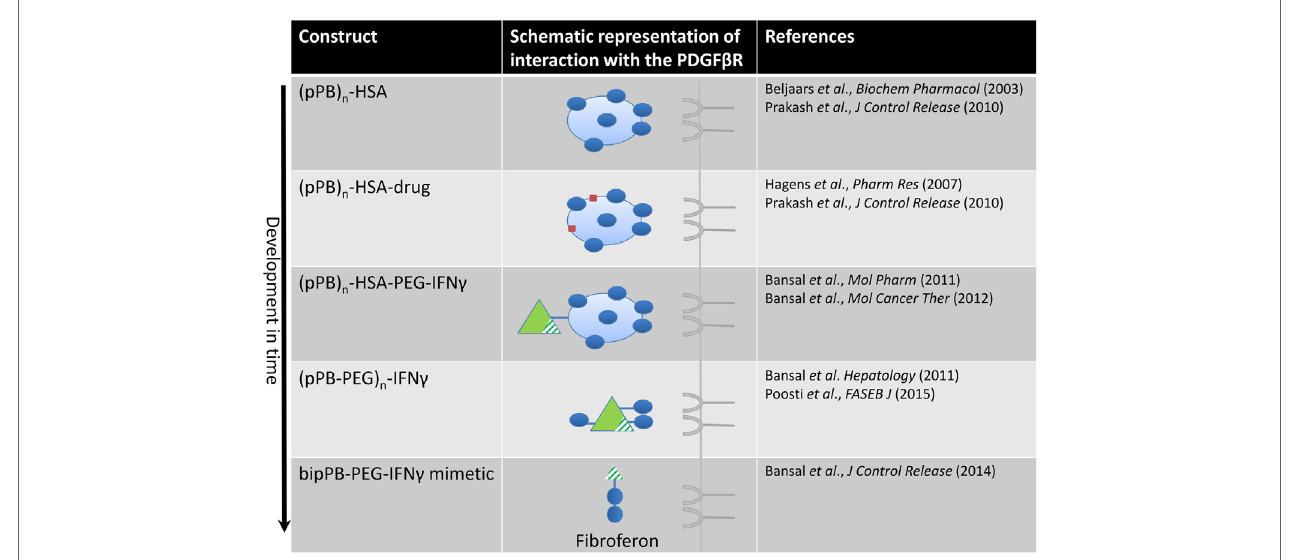
FiGURe 2 | Design of constructs directed at the PDGF β receptor in time, finally leading to the development of Fibroferon . The first PDGF β R-targeted product was the carrier pPB-HSA in which several (on average n = 10) groups of pPB were randomly attached to human serum albumin (HSA), in order to allow multivalent interaction with the PDGFR. Several other constructs, comprising a therapeutic entity (drug or protein) coupled to this carrier, were subsequently developed and tested in vivo . In the final step, the structure was simplified by omitting the albumin protein core and applying low-molecular-weight PEG to couple truncated IFN γ to BipPB, to create divalent interaction of truncated IFN γ with the PDGF β